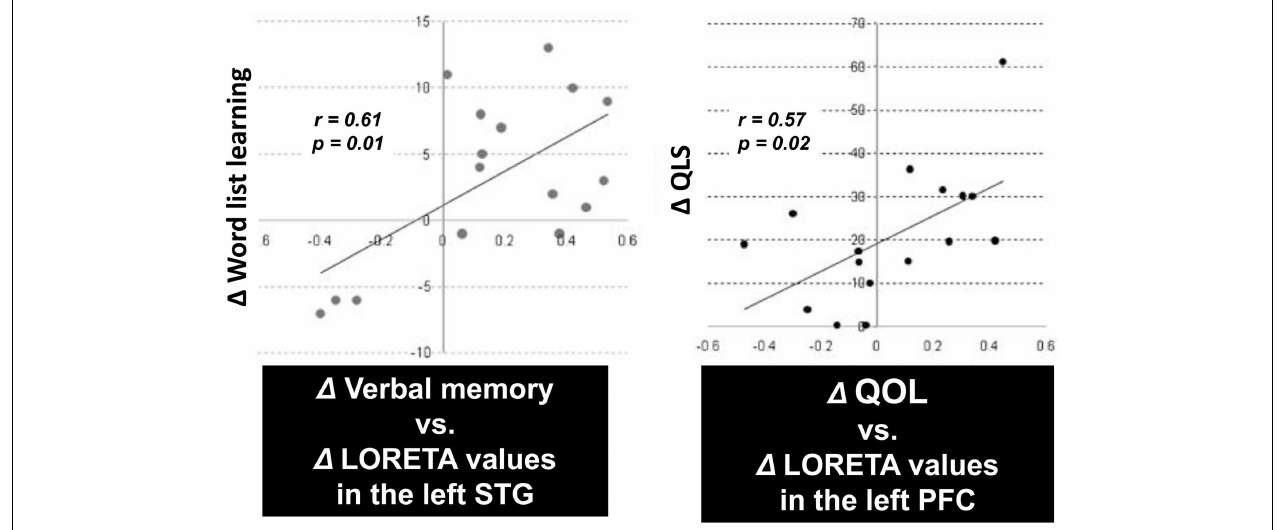
P300 current density in the left superior temporal gyrus (STG) ( left ). Also, the improvement of the Quality of Life score was correlated with enhancement of P300 current density in the left prefrontal cortex (PFC) ( right ).